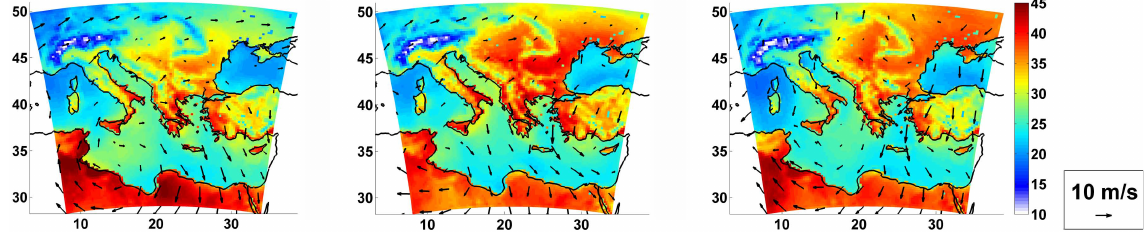
Fig. 5. Daily maximum 2 m temperature ( ◦ C) and mean 10 m wind vectors (10 m s − 1 vector shown for scale in legend) averaged over the periods 24–26 June (left), 22–24 July (middle), and 22–24 August (right) in 2007. The winds are averaged separately in each horizontal direction ( u and v wind components), and both temperature and wind averages are based on hourly output from the WRF-Chem model (i.e. 72-h averages for the